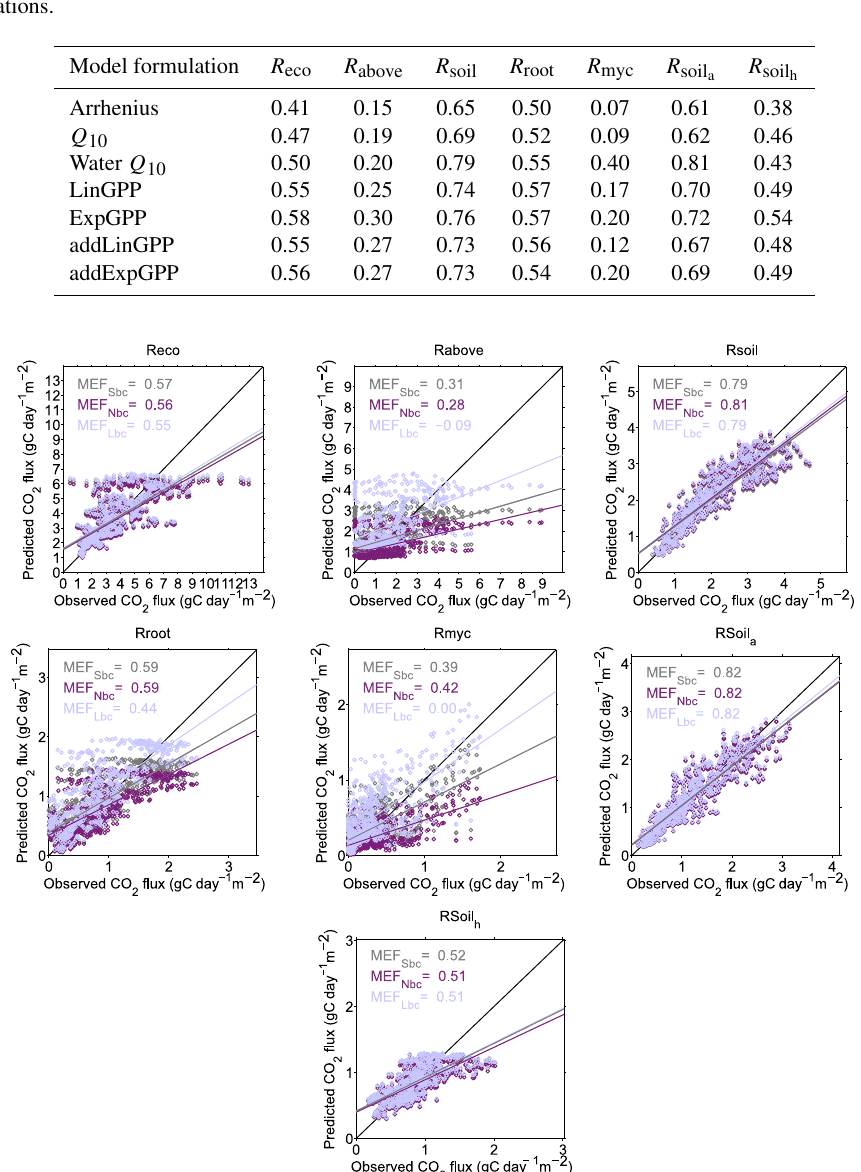
, and R soil , and back-transformed with three types of residual a h